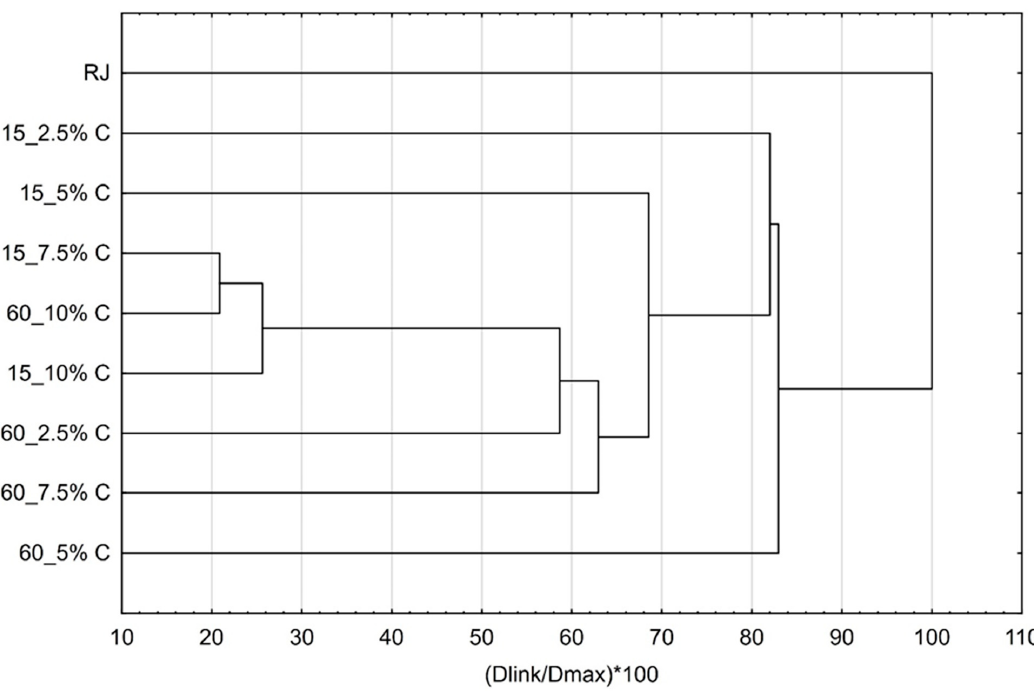
Figure 9. Cluster analysis of flavor profiles of cellulose/raspberry complexes after preparation.